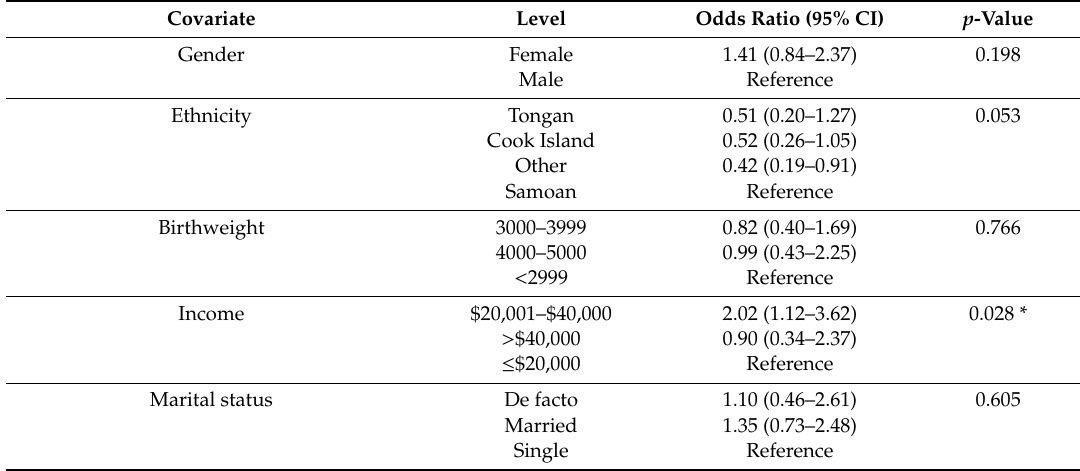
Table 3. Univariate logistic regression result of total behavioral problem and associated